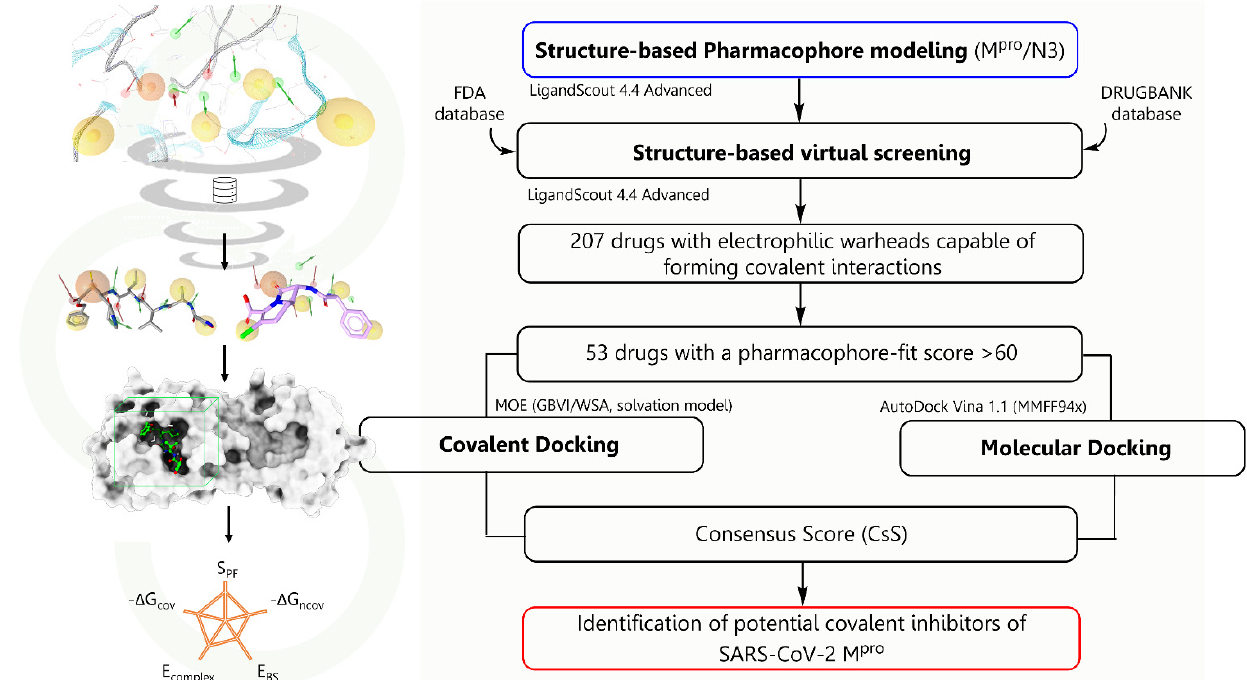
Figure 2. Overview and workflow implemented in the combined structure-based approach with pharmacophoric modeling, virtual screening, non-covalent docking and covalent docking.